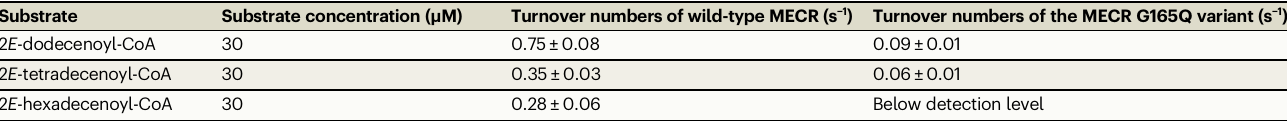
Table 2 | Speci fi c activities of wild-type MECR and the MECR G165Q variant with C12, C14 and C16-CoA substrates Substrate Substrate concentration